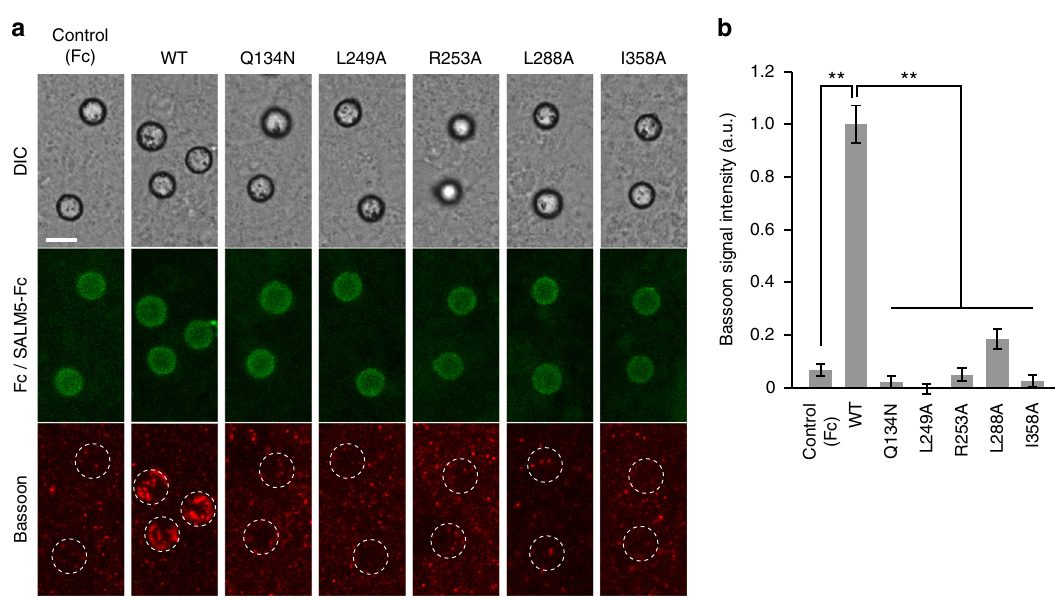
Fig. 4 Presynapse-inducing activities of SALM5 mutants. a Co-cultures of cortical neurons and beads conjugated with Fc or SALM5 mutants fused to Fc. Co-cultures were stained with anti-Fc (middle row, green) and anti-Bassoon (bottom row, red) antibodies. Corresponding differential interference contrast (DIC) images are on the top row. Scale bar, 5 μ m. b Staining signal intensities of Bassoon on beads conjugated with Fc or SALM5 mutants fused to Fc. All values represent mean ± s.e.m. Statistical signi fi cance was evaluated by one-way ANOVA followed by post hoc Tukey ’ s test. ** p < 0.01, compared with wild-type SALM5-Fc. n = 28 – 33